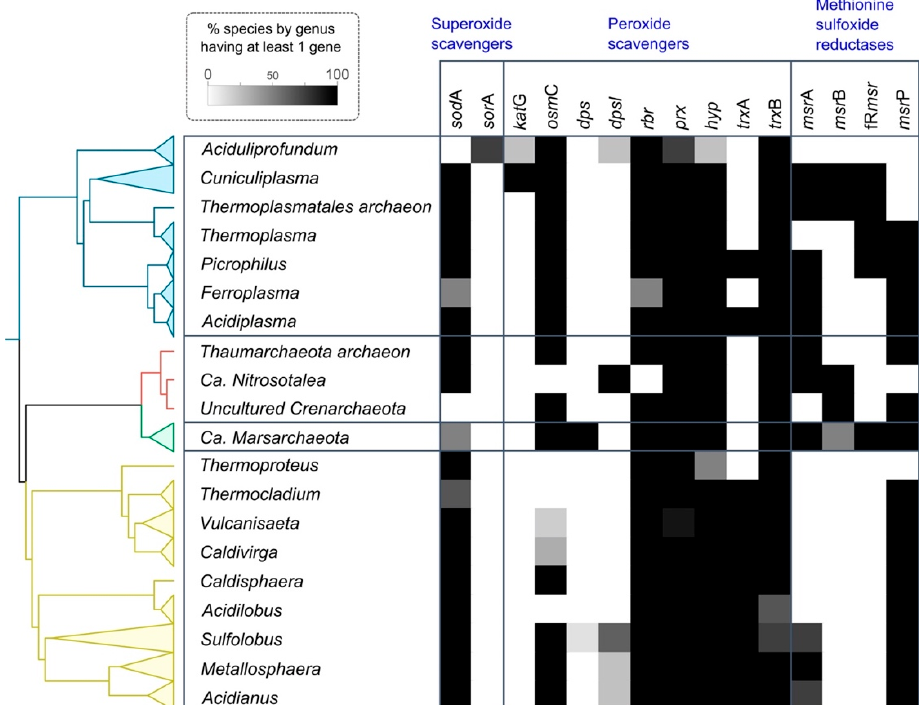
Figure 7. Summary of predicted oxidative stress response proteins in acidophilic archaea. The heatmap depicts the presence of each protein as a percentage of the genomes it was identified in (see insert scale-bar). Genomes were grouped at the genus level. Colors correspond to phylum level with yellow for Crenarchaeota, red for Thaumarchaeota, green for Marsarchaeota and blue for Euryarchaeota.